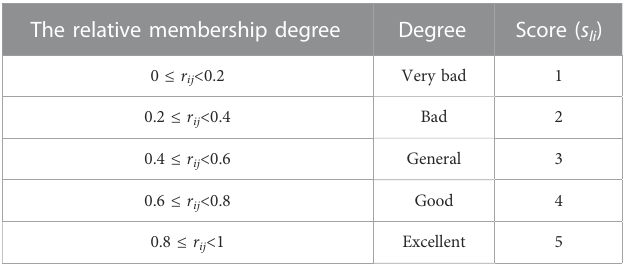
TABLE 3 Assignment scale.